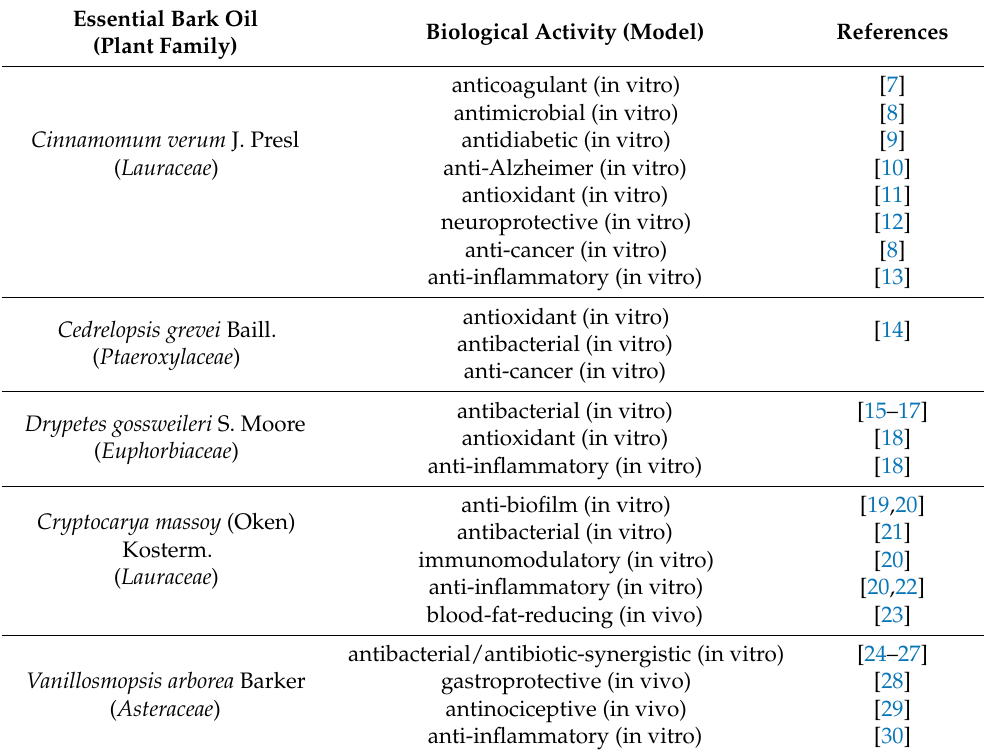
Table 1. Major biological activities of selected bark